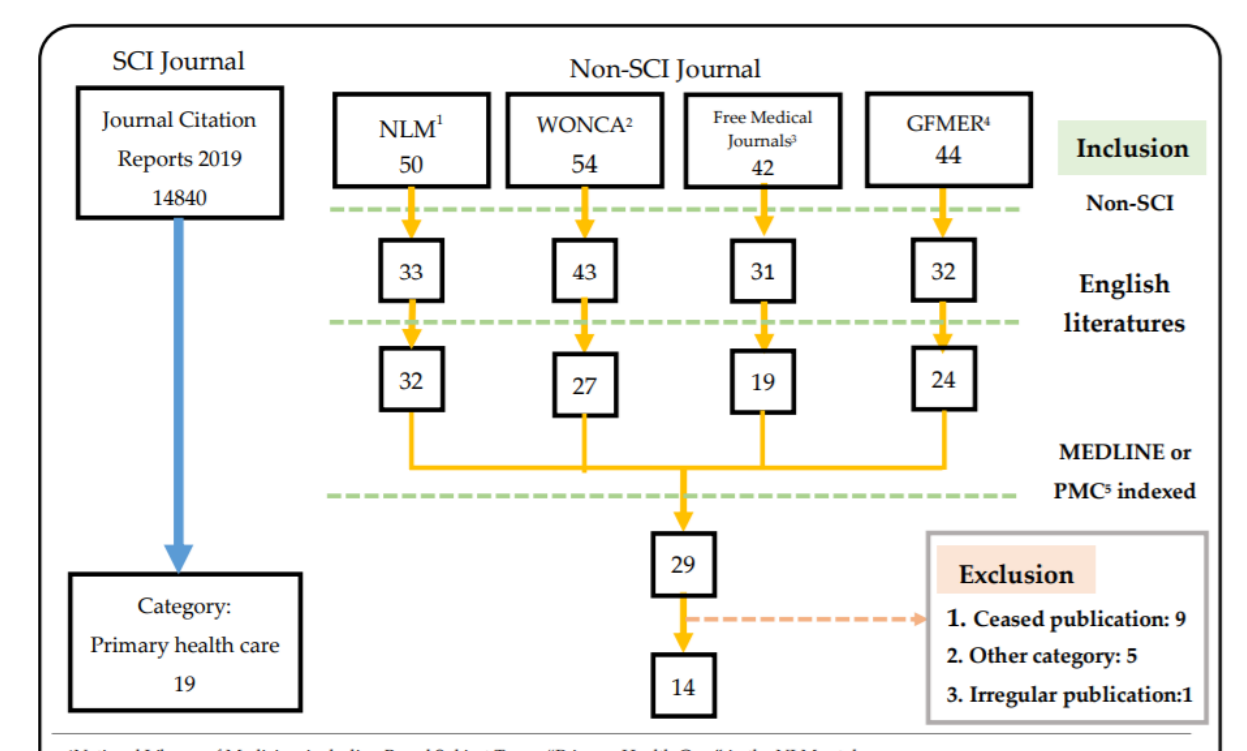
Figure 1. Research method of collection of family medicine journals.